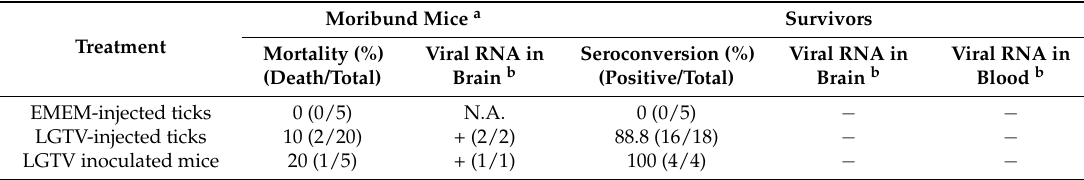
Table 4. Langat virus transmission from Haemaphysalis longicornis to mice.